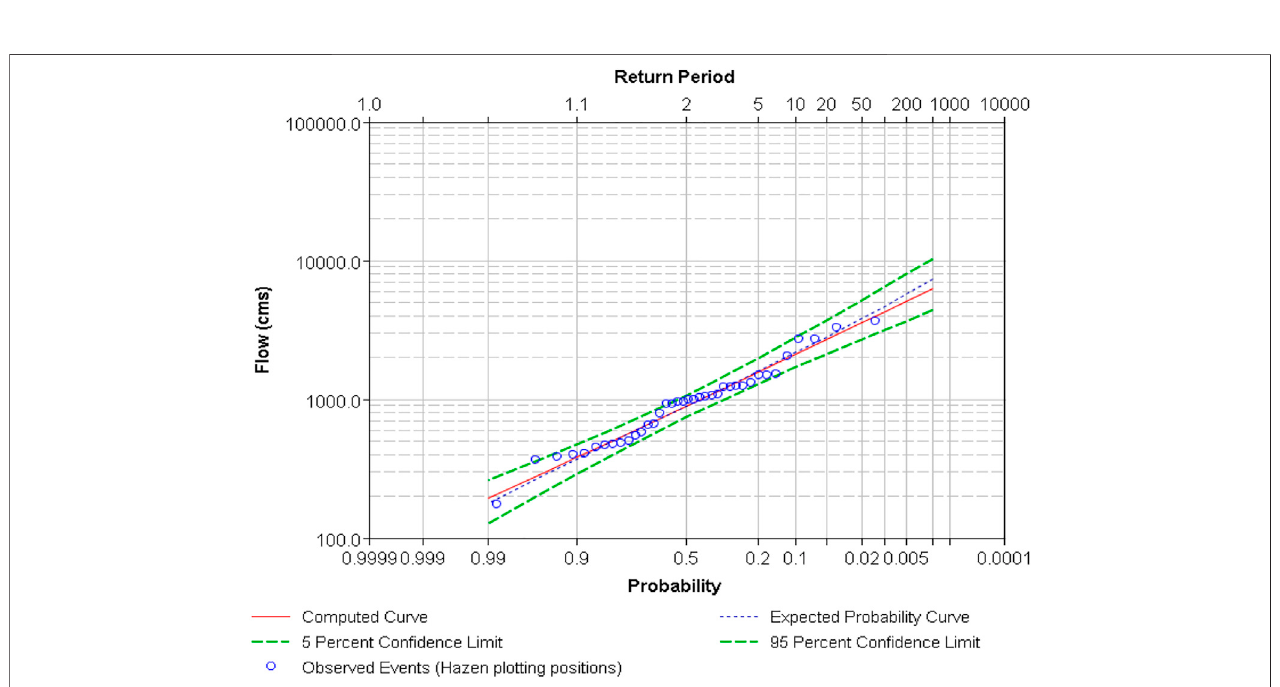
FIGURE3| CharacteristicsofHuongSondistrict (A) geographiclocationofHuongSondistrictinHaTinhProvince (B) andgeographiclocationofHaTinhProvince in Vietnam (C) .